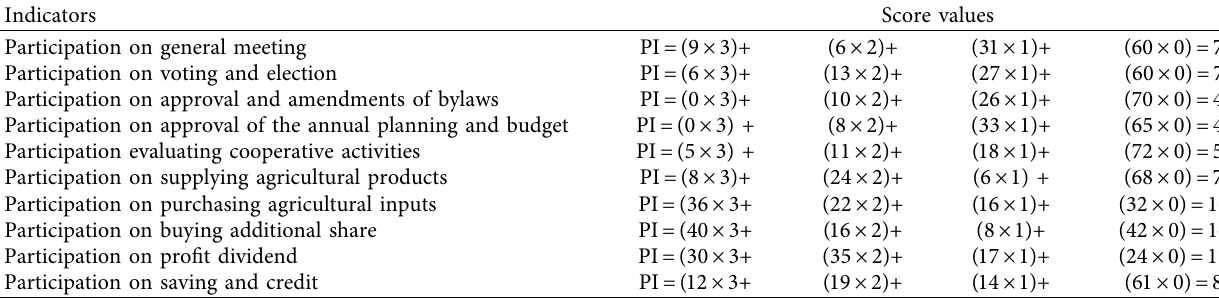
Table 6: Participation index and score values.